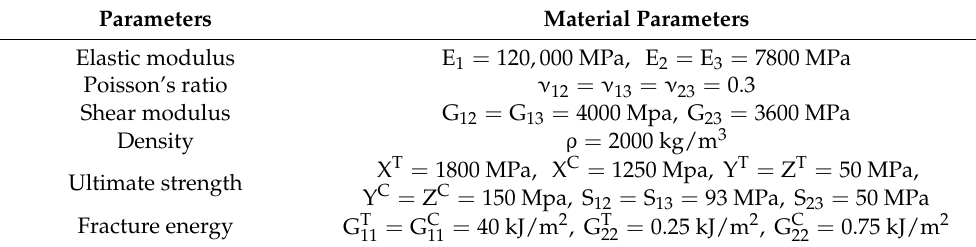
Table 5. Carbon fibre composite material parameters